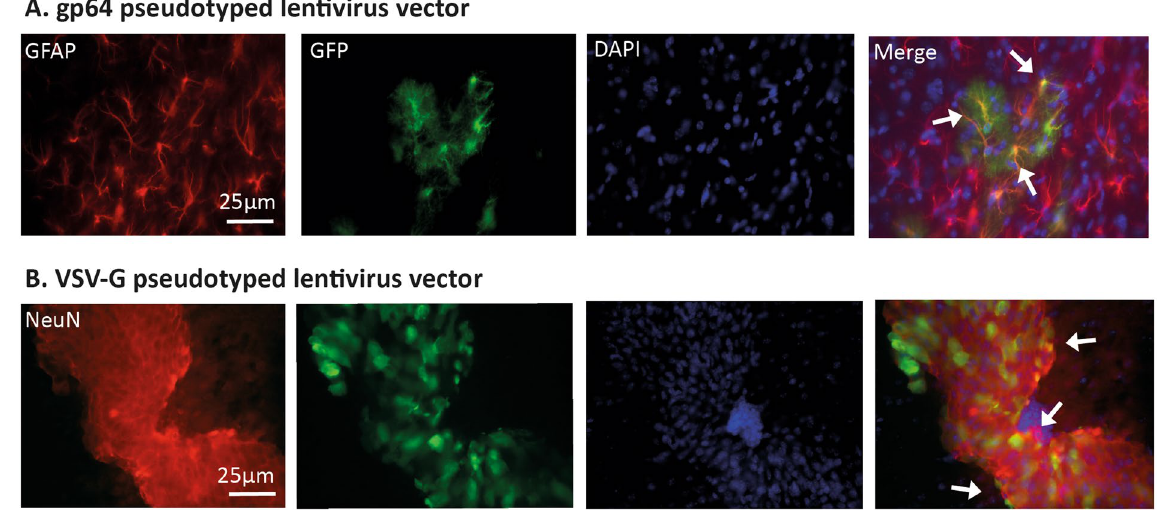
Figure 3. Astrocytic targeting with gp64 pseudotyped lentivirus vector and neuronal targeting with VSV-G pseudotyped lentivirus vector. Brain sections from injected mice were used to determine the cell types expressing GFP after neonatal intracranial injections of gp64 or VSV-G SFFV lentivirus vector. ( A ) GFP with fibrotic GFAP astrocytic signals were co-localised. This is shown with the white arrows in the merge column. ( B ) GFP co-localised with NeuN in the CNS of mice which received the VSV-G SFFV vector (white arrows). All the images were taken at × 40